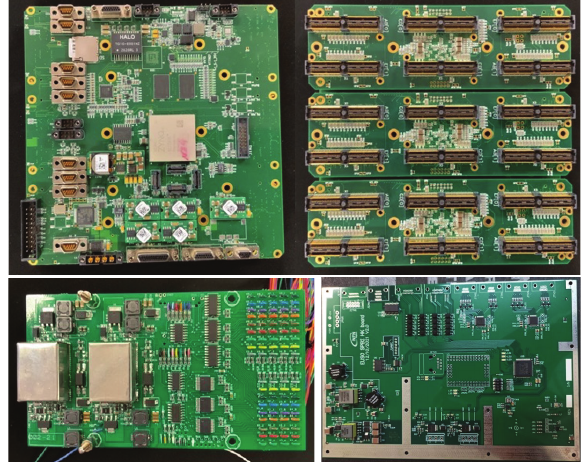
Figure 4. JEM-EUSO electronics. Top: Zynq board with FPGA for data acquisition and trigger. Bottom left: HVPS DC-DC con- trol board. Bottom right: data processing and control board.